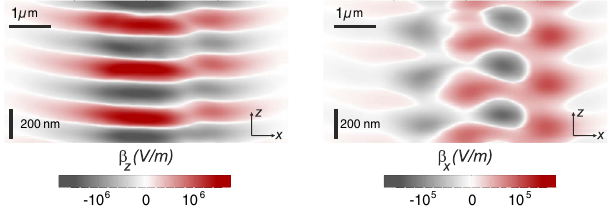
FIG. 12. Maps of the measurement vectors. We shows the XZ Þ obtained with the ; β maps of the measurement vectors ð β z x spatial interference measured on the red-probe-laser reflection ð r Þ . Measurement vectors defined as β ≡ photodiode signal P R 0 ∇ P are measured dynamically, by modulating the piezo stage R supporting the nanowire with constant tones at 80 and 85 Hz along the x and z axes (approximately 5 nm of amplitude) and FIG. 14. Correction for blind measurement positions in multi- demodulating the photodiode output signal ( 1 - 10 μ W of 633-nm frequency responses. We give an illustration of the local bar- probe laser are typically employed). Those measurements are ycentric smoothing employed in the data analysis to compensate acquired simultaneously during the multifrequency response for the reduction of readout sensitivity observed in the readout maps shown in Fig. 4 of the main text, on a 400 × 400 pixel channel at the interference extrema. The cavity transmission is map, with 100 ms acquisition time per point. The z periodicity shown on top, while the bottom curves represent the norm of the observed corresponds to half the probe-laser wavelength measurement vector. Blind positions are marked by gray dashed (633 nm). In most positions, the measurement vectors e β ¼ lines. The central panel shows the force measured before (dots) β = j β j are almost aligned with the optical axis e . z and after (line) the local weighted averaging explained in the identify nodes and antinodes of the intracavity field; the bottom curve represents the norm of the measurement vector, which presents blind positions (marked by gray dashed lines). The central panel shows the force measured before (dots) and after (line) the barycentric correction. We note that because of the large signal-to-noise ratio observed in our measurement conditions (force signal 20 dB above the thermal noise and 60 dB above the background for 5-Hz resolution bandwidth), it is always possible to detect the driven force, even very close to the blind positions. The barycentric averaging thus serves to compensate for the errors arising in the evaluation of the measurement vectors close to the blind positions.